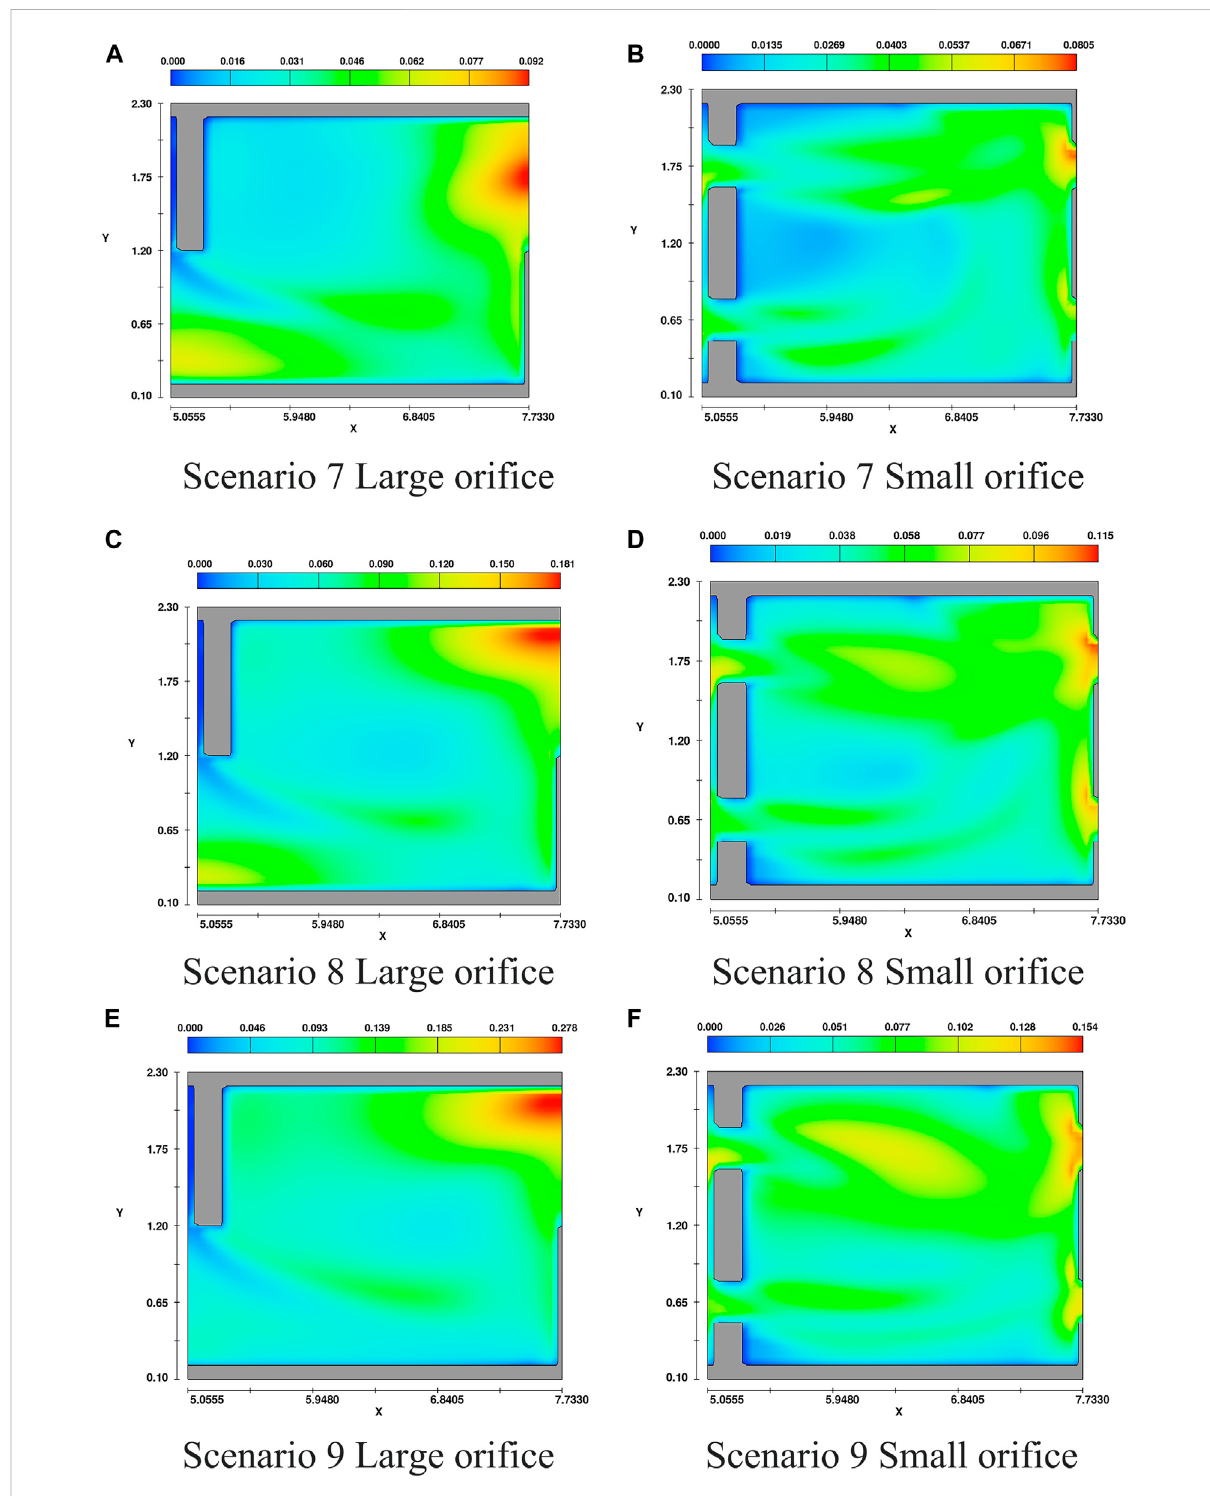
FIGURE 14 Turbulent kinetic energy diagram under different